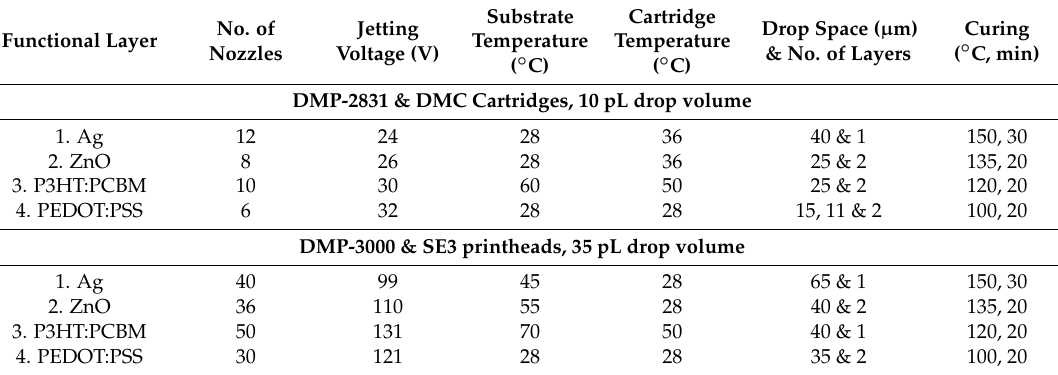
Figure 3. Images exhibiting the suitable jetting waveforms for the different inks implemented for depositing the functional layers of the OPV devices, using ( A ) DMP-2831 with DMC printheads; and ( B ) DMP-3000 with SE3 printheads. Table 1. The deposition parameters optimized for the development of functional layers dedicated to the manufacturing of OPV devices.